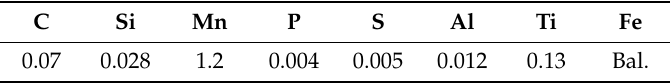
Table 1. Chemical composition of experimental steel (wt